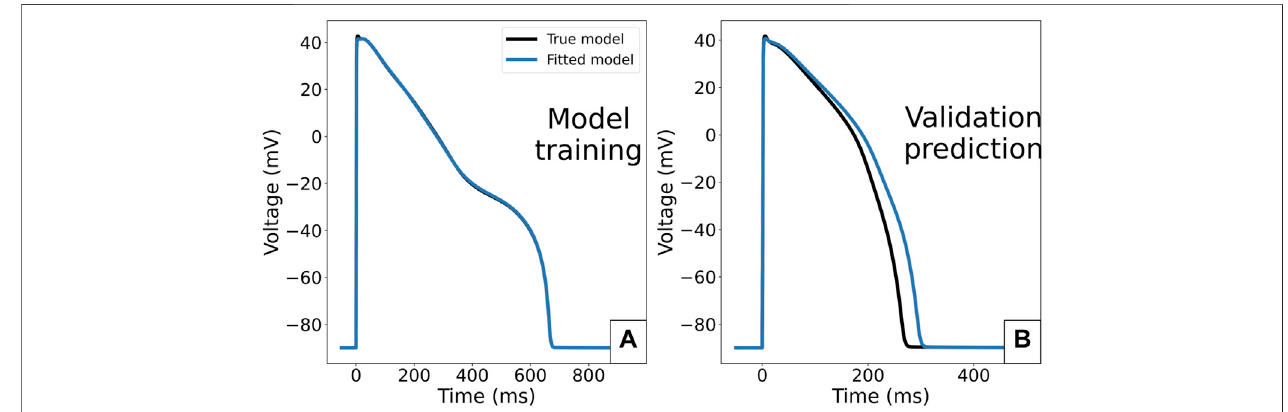
FIGURE 11 | Consequence of fi tting the ORd-CiPA model in case of multiple stable limit cycles for the same Γ 0 value. (A) : ORd-CiPA fi tted with initial [ Na + ] i (cid:1) 7 . 3 mM under 95% of I Kr block is able to reproduce the synthetic data generated with initial [ Na + ] i (cid:1) 15 mM (APs superposed). (B) : predictions for no I Kr block. Despite the good fi t to I Kr block data in panel (A) , incorrect parameter values are retrieved from fi tting, and the prediction of the calibrated model is